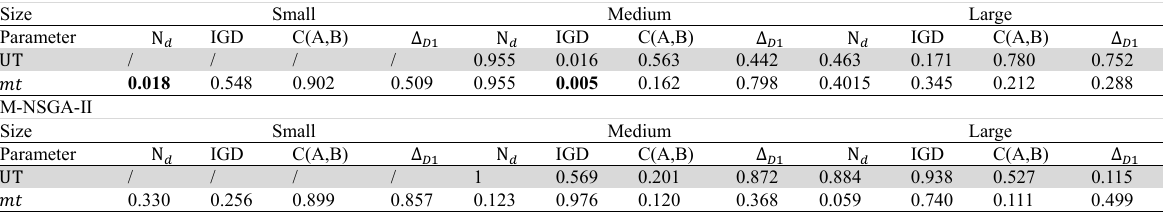
Significance level of the different algorithms NSGA-